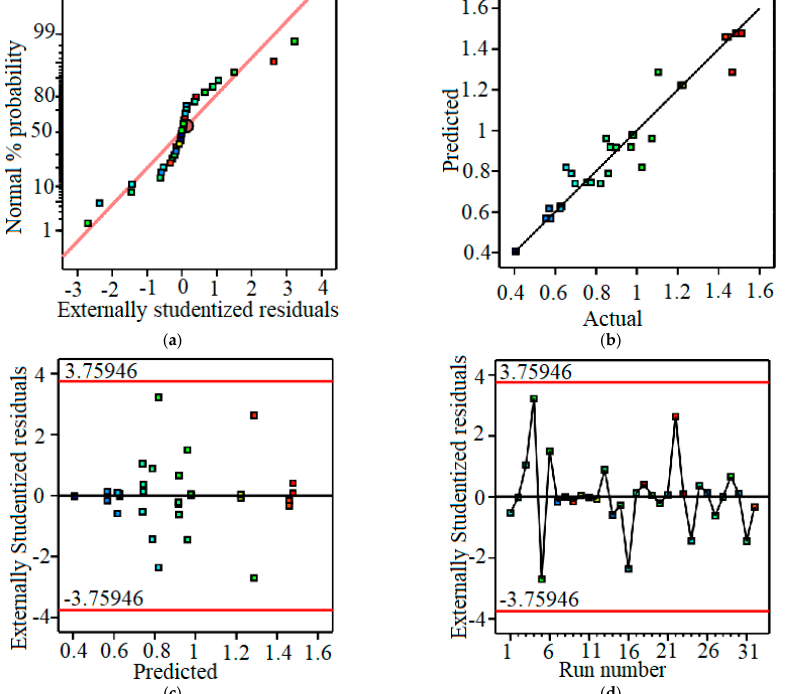
Figure 5. Model fit chart: ( a ) — normal plot of residuals (the reference line is red); ( b ) — predicted vs. actual (the reference line is black); ( c ) — residual vs. predicted (the limit line is red and the reference line is black); ( d ) — residual vs. run (the limit line is red and the reference line is black).